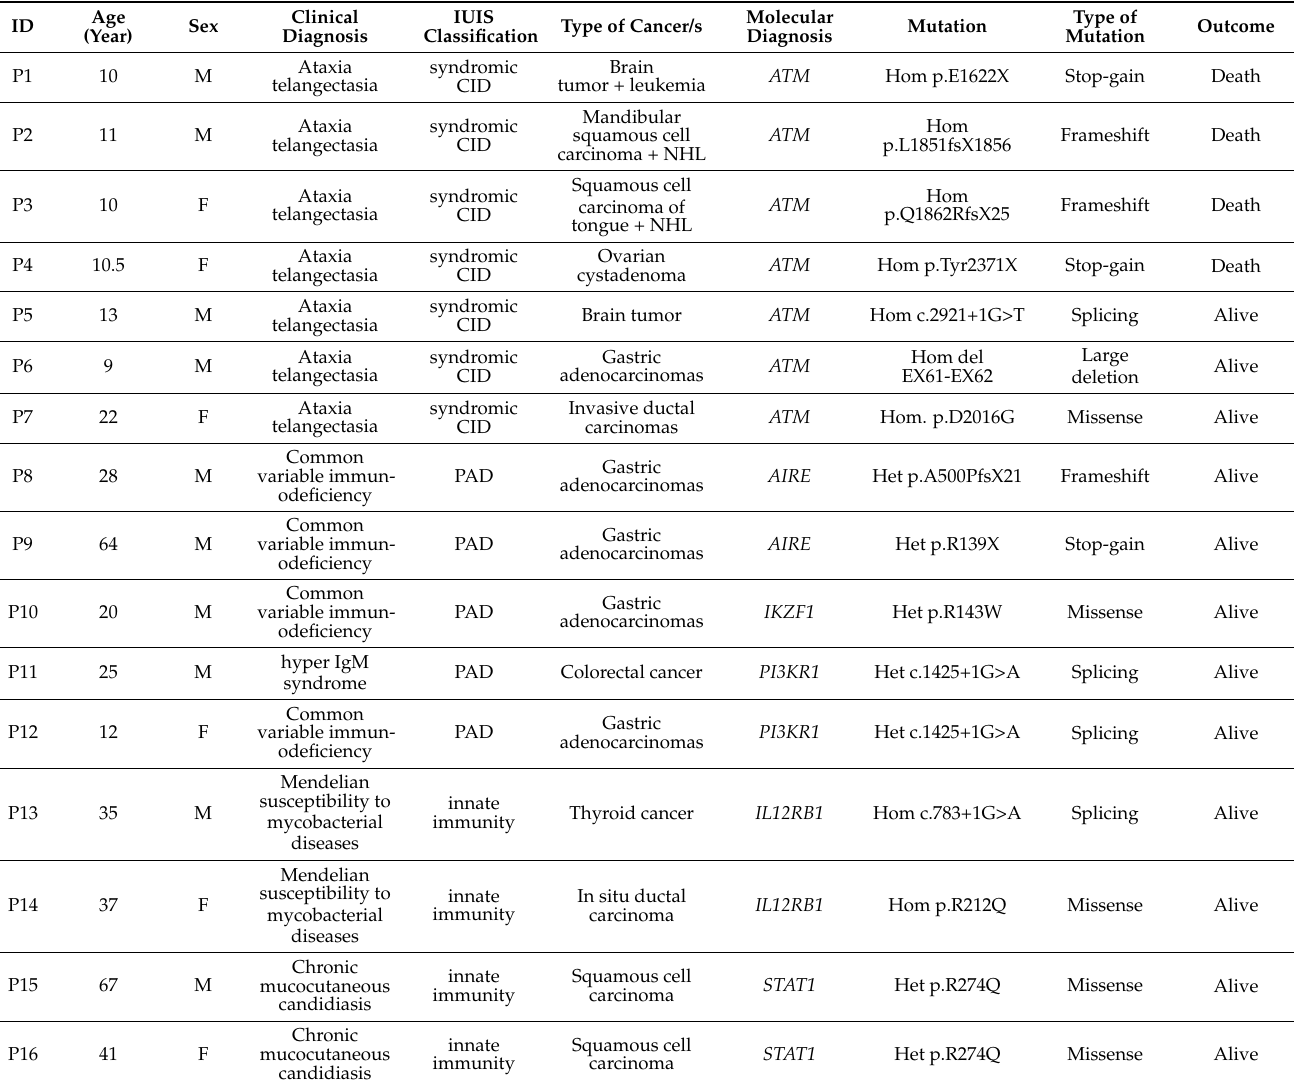
Table 3. Details of genetic studies of patients with 16 IEI patients with non-hematologic malignancies and defined molecular